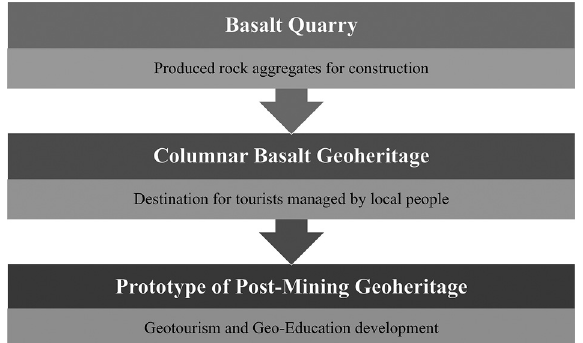
Fig. 11. Timeline development of Nang Rong Columnar Jointed Volcanics from active quarry to post-mining